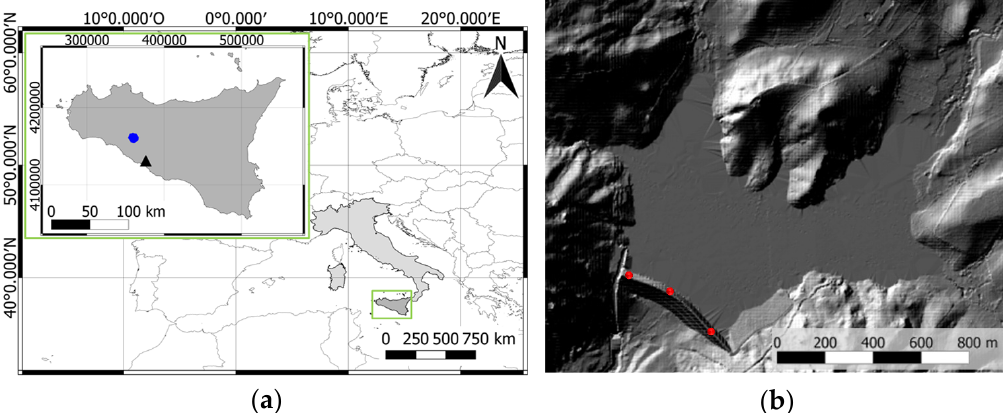
Figure 1. The location of the study area ( a ) is Sicily island-Italy (dark and light grey, respectively), EPSG 4327; the upper left box reports a zoom of the island with the Agrigento permanent station (black triangle) and the Magazzolo reservoir (blue dot), EPSG 6708 and ( b ) hillshade of the dam–reservoir system derived from a digital surface model by setting azimuth and elevation of the incident light at 315 and 45 degrees, respectively). Superimposed the positions of the GNSS stations (red dots).